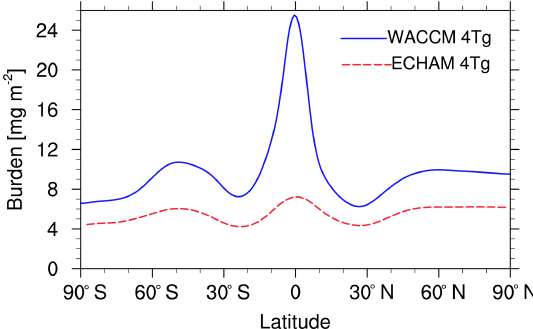
Figure 4. Zonally averaged sulfate burden of injections of 4Tg ( S ) yr − 1 for WACCM and